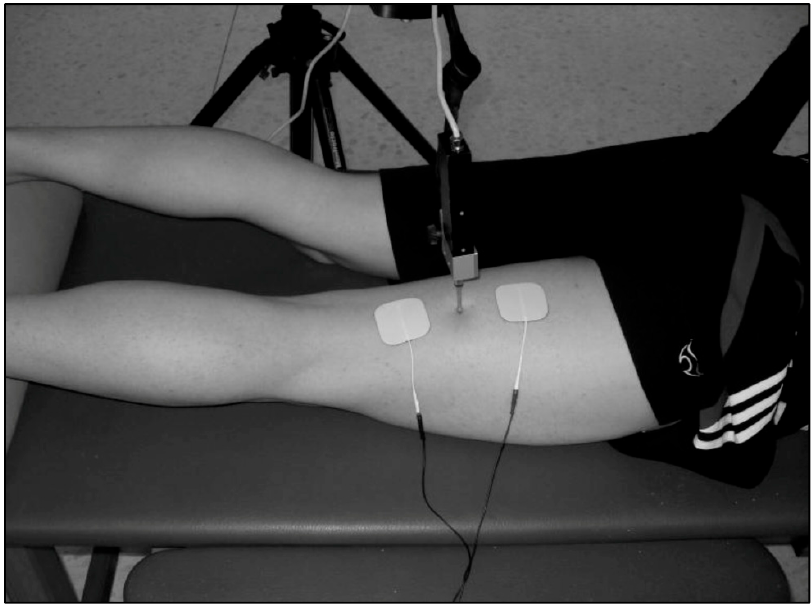
Figure 2. Position of the dominant knee and sensor tip perpendicular to the muscle belly, with electrodes symmetrically placed 3 cm from the sensor.